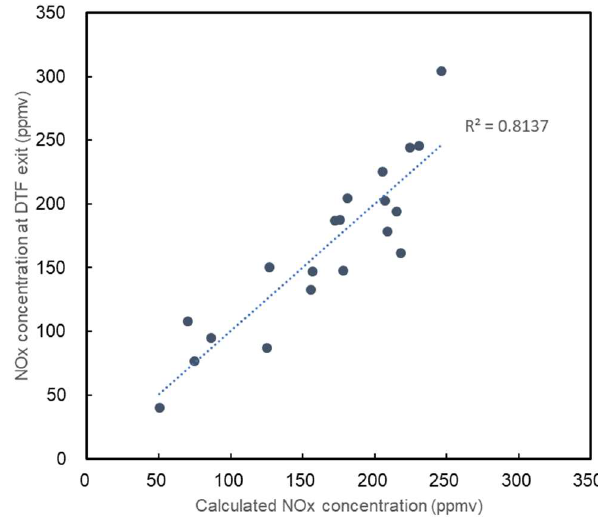
Appl. Sci. 2019 , 9 , x FOR PEER REVIEW Figure 5. Relation between NOx concentration at the DTF exit and calculated NOx concentration.